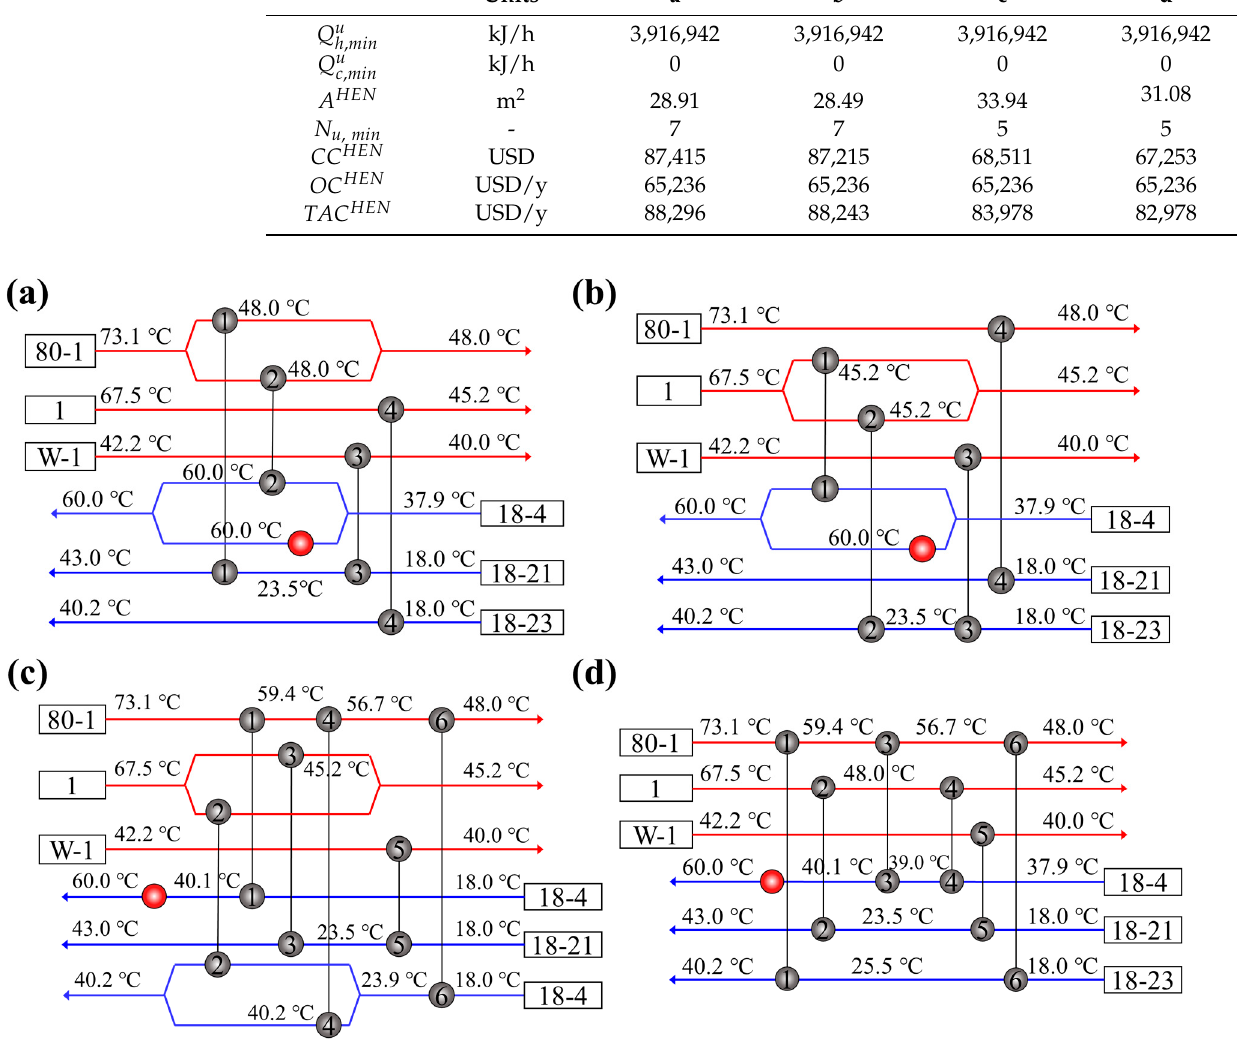
Figure 5. Grid diagrams of the retrofitted HEN in the wastewater heat recovery systems: ( a ) design a; ( b ) design b; ( c ) design c; ( d ) design d.